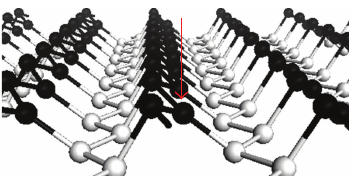
Figure 2: Atomic configuration of optimized Si (110)-(1 × 1) surface. Black (white) balls indicate the Si atoms in the first (second)